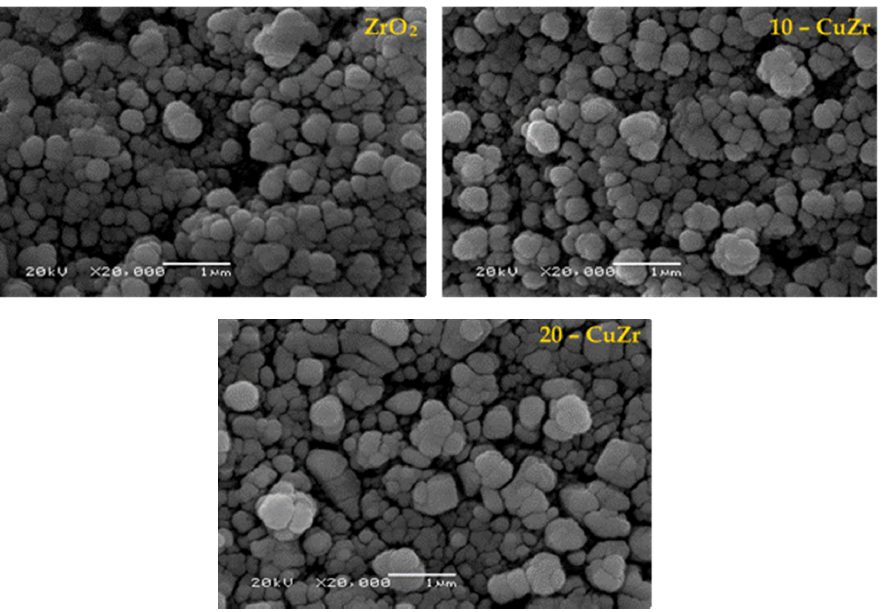
Figure 3. SEM images of ZrO 2 and CuO ‐ ZrO 2 samples.